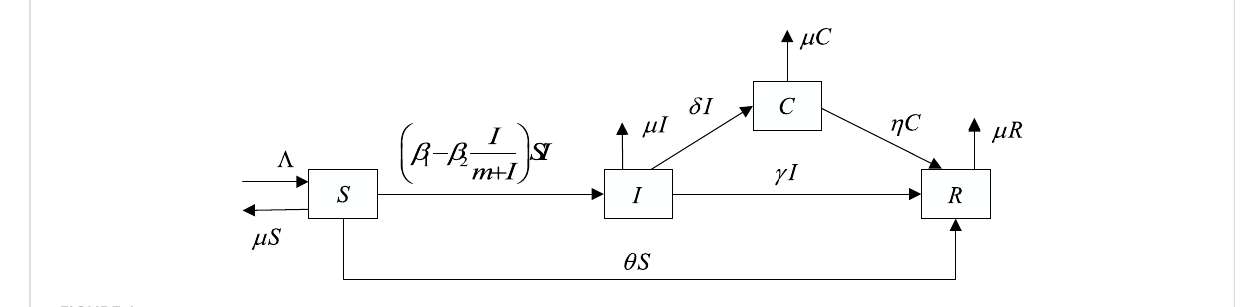
FIGURE 1 Schematic diagram of the rumor under the in fl uence of media